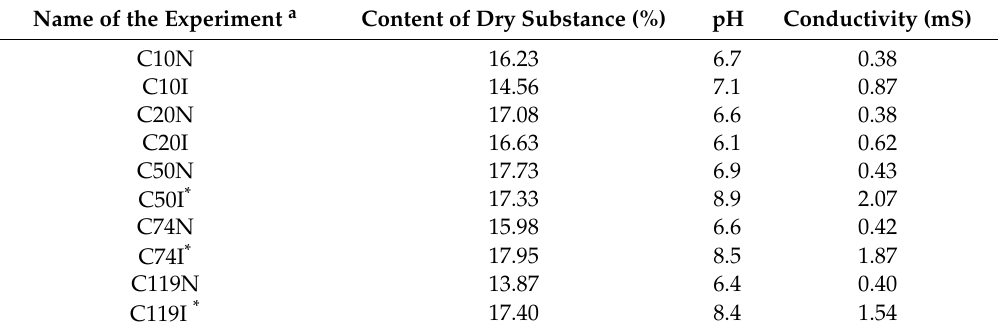
Table 2. Selected material parameters obtained at the end of the composting process. Name of the Experiment a